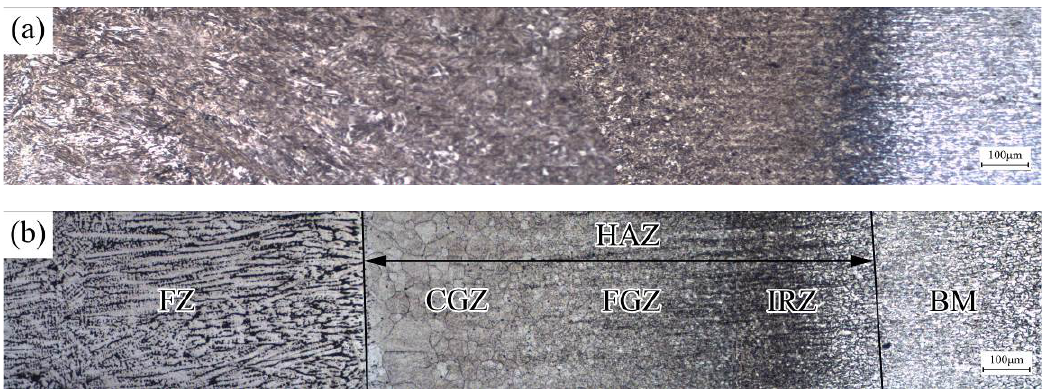
Figure 6. Distribution of ( a ) metallographic structure and ( b ) grain morphology of weld joint.